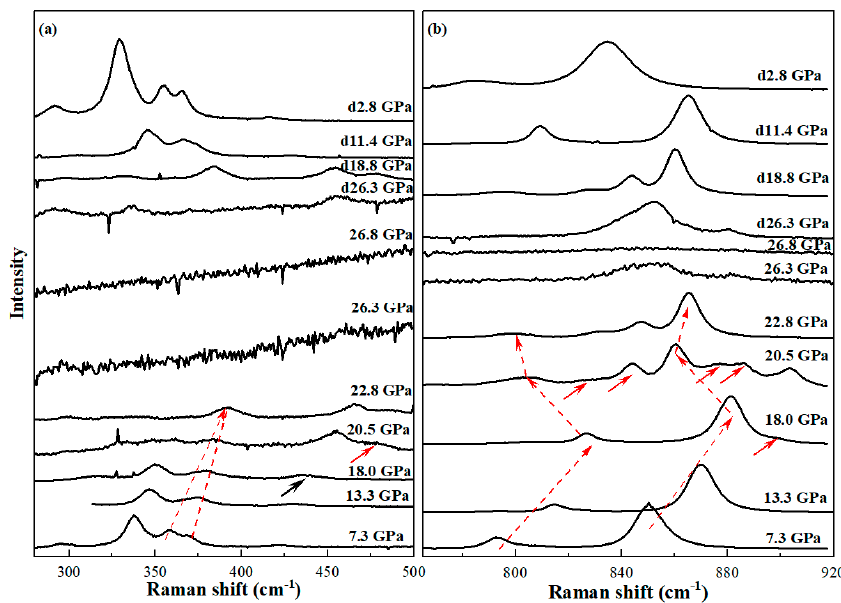
Figure 6. Representative Raman spectra of vanadinite at different high pressures. ( a ) Raman shifts between 250 and 500 cm − 1 . ( b ) Raman shifts between 700 and 900 cm − 1 . The highest pressure is 26.8 GPa and the data between d26.3 GPa and d2.8 GPa were collected during decompression. Dash lines with arrows serve as guide for eyes showing the direction of variation in these maxima. The red and black arrows point to the new bands and the high ν 4 bands of vanadinite at 300 K in a diamond anvil cell, respectively. Minerals 2021 , 11 , x FOR PEER REVIEW